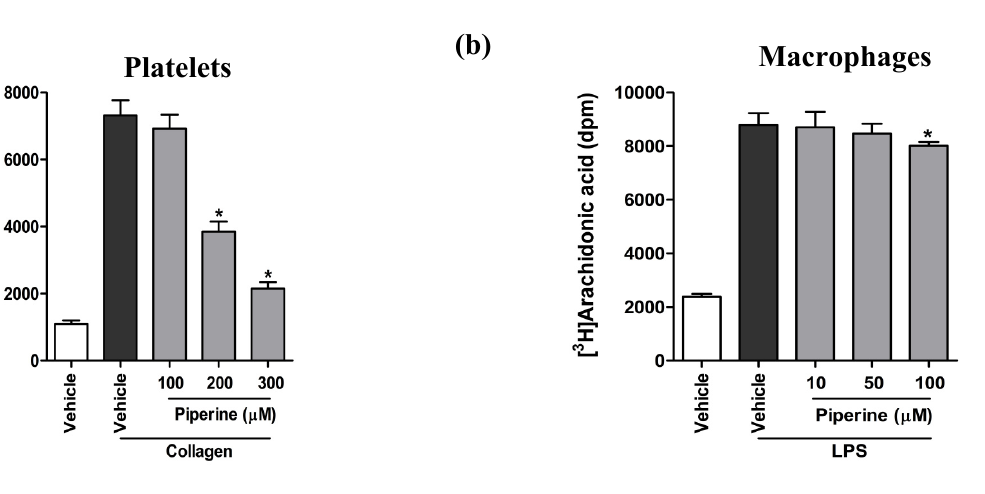
Figure 3. Piperine suppressed the liberation of the arachidonic acid in collagen-stimulated platelets, but not in LPS-stimulated RAW264.7 cells. [ 3 H]AA-labeled platelets and RAW264.7 cells were treated with a range of concentrations of piperine (gray bars) or vehicle (DMSO, white and black bars), as presented in the graphs. The liberation of [ 3 H]AA in platelets stimulated by 10 μ g/mL collagen ( a ) and in RAW264.7 cells stimulated by 1 μ g/mL LPS ( b ) was determined by measuring the radioactivity. Data are expressed as means ± S.D. of three separated experiments. * p < 0.05 vs. vehicle controls (black